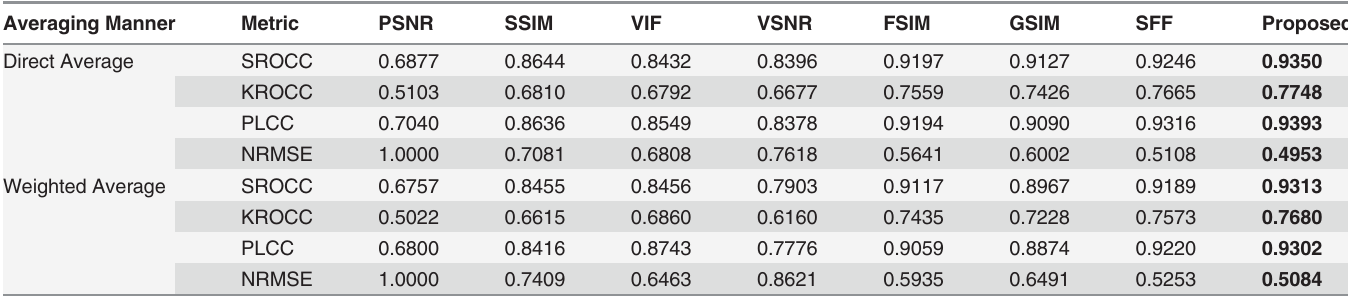
Table 3. Average performance on six